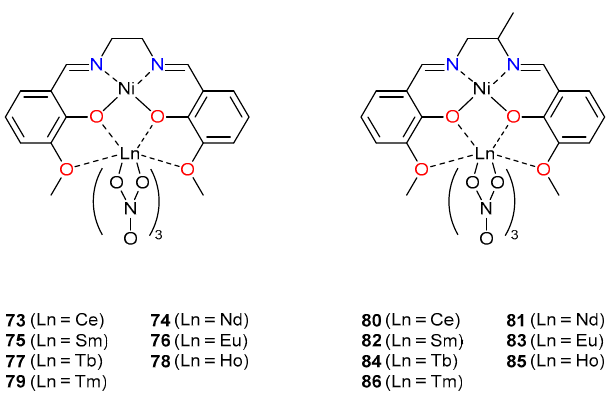
Figure 14. Ni–Ln(III) salen complexes 73–86 [59–61].